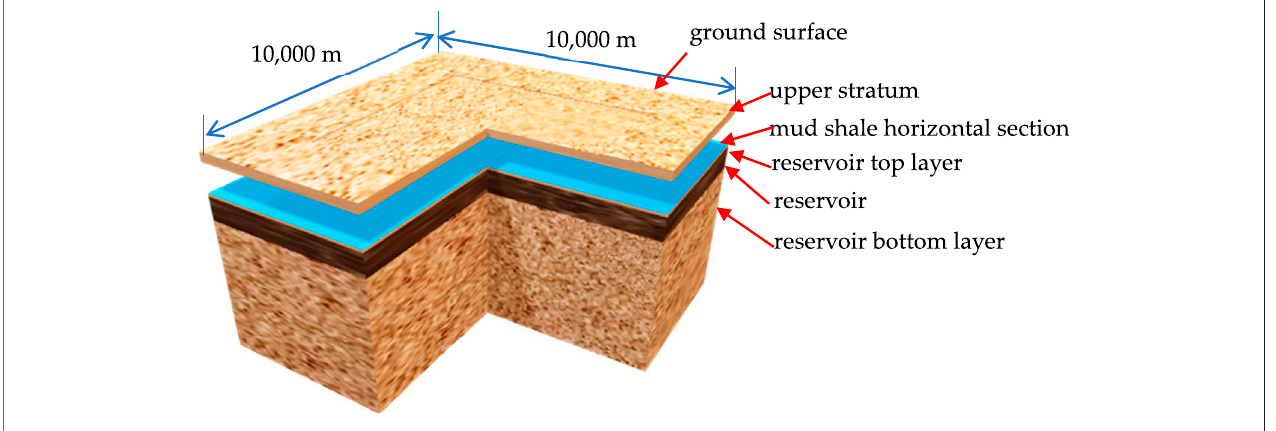
FIGURE 7 | Geometric view of the fi nite-element model.